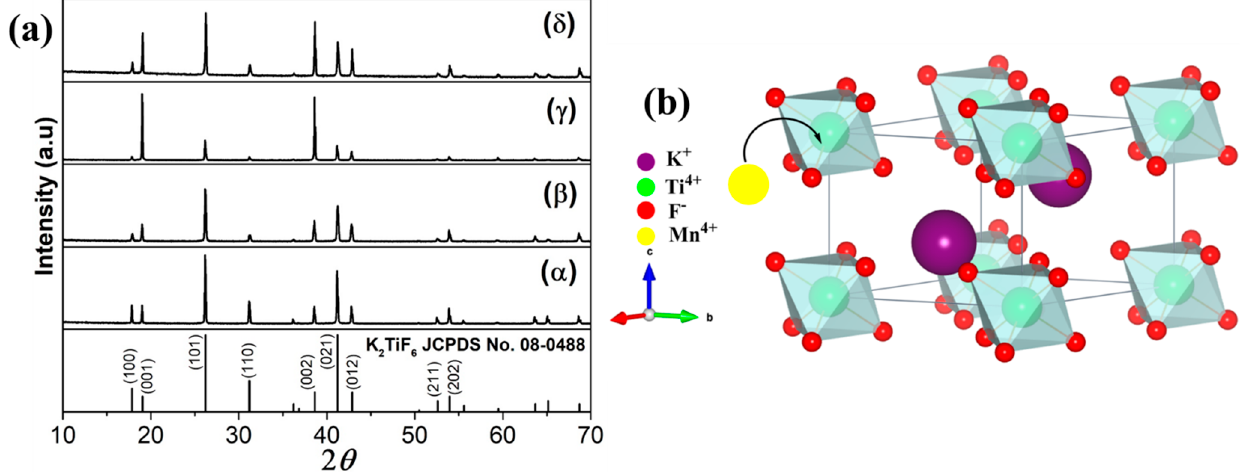
Figure 1. ( a ) XRD patterns of KTFM prepared with various OA/SDS weight ratios of ( α ) 0.0, ( β ) 2.0, ( γ ) 6.0 and ( δ ) 10.0. ( b ) Picture of K 2 TiF 6 structure viewed along the [100] direction.